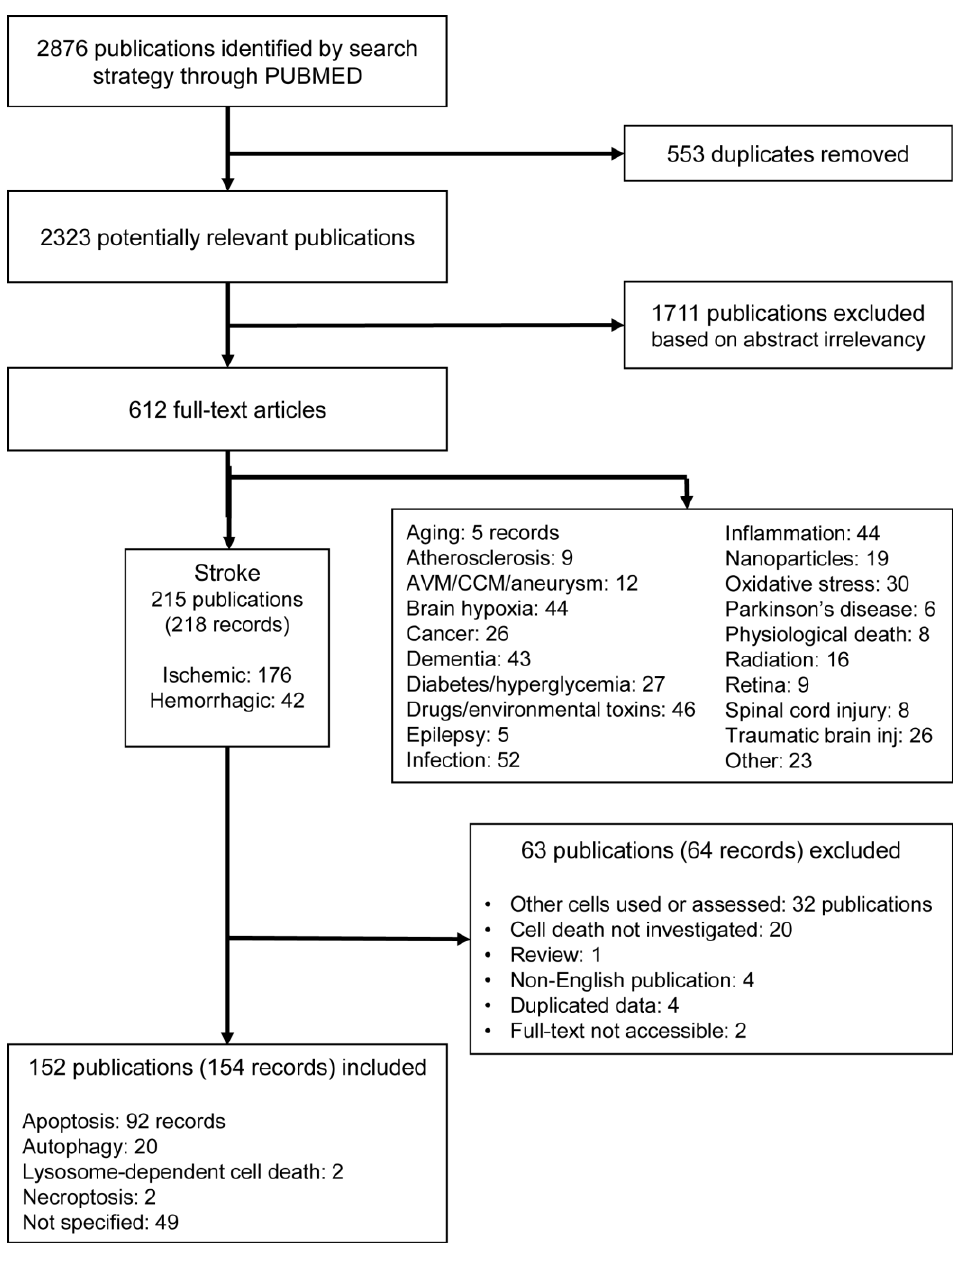
FIGURE 2: PRISMA flow chart of the systematic search on brain EC